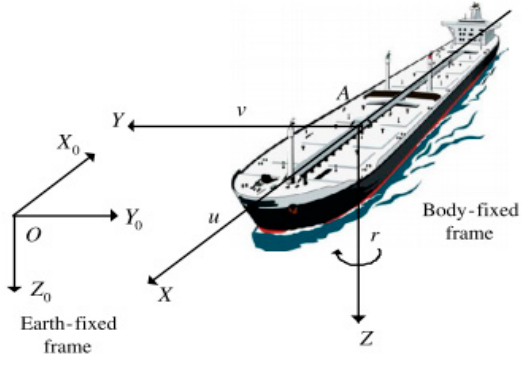
Figure 1. The marine surface vessel in coordinate system.